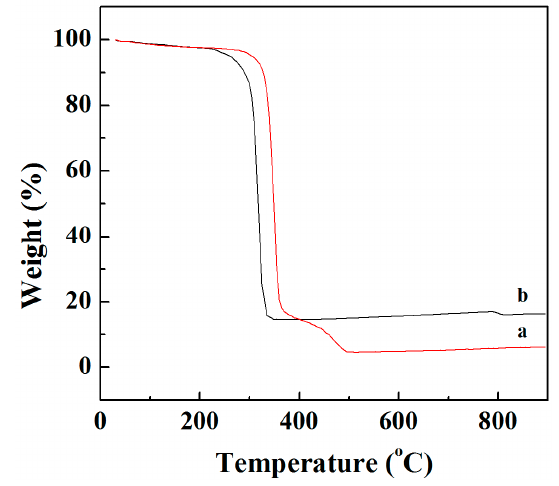
Figure 3. Thermogravimetric analysis (TGA) curves of the (Curve a) iron/palladium (Fe/Pd)-free and (Curve b) Fe/Pd nanoparticle (NP)-assembled filter paper.